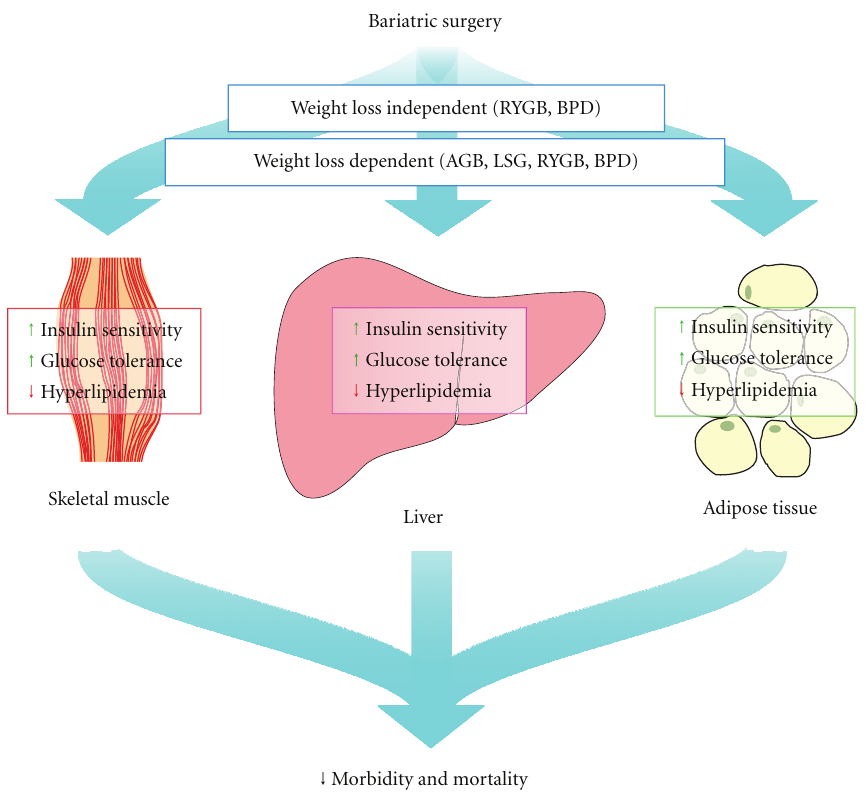
Figure 1: Scheme of the metabolic changes in response to adjustable gastric band (AGB) and laparoscopic sleeve gastrectomy (LSG), whose metabolic e ff ects are mainly dependent on weight loss, and Roux-en-Y gastric bypass (RYGB) and biliopancreatic diversion (BPD), whose metabolic e ff ects are also independent of weight